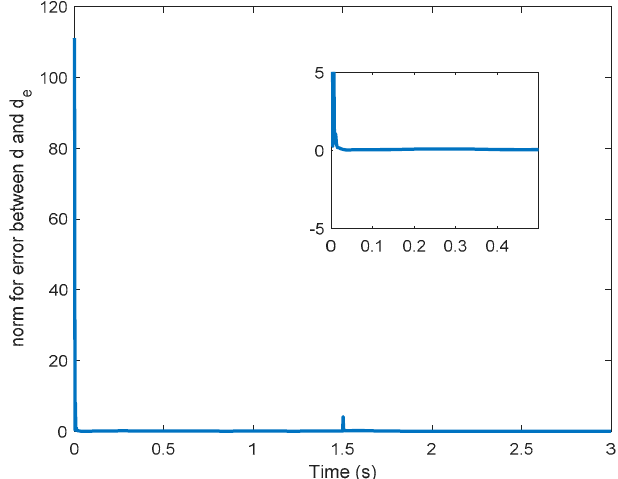
Figure 6. Error between unknown and estimated perturbations.